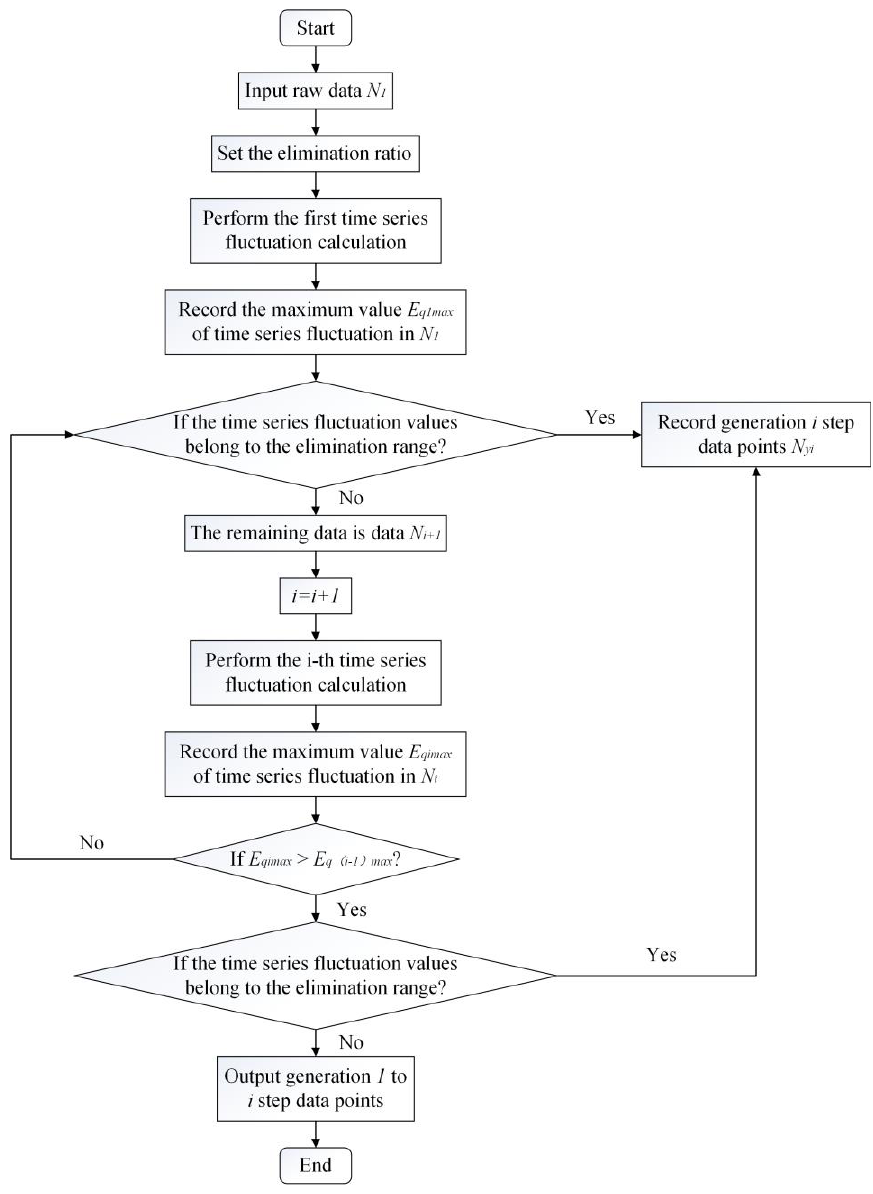
Figure 4. Identification flow chart of step data points.